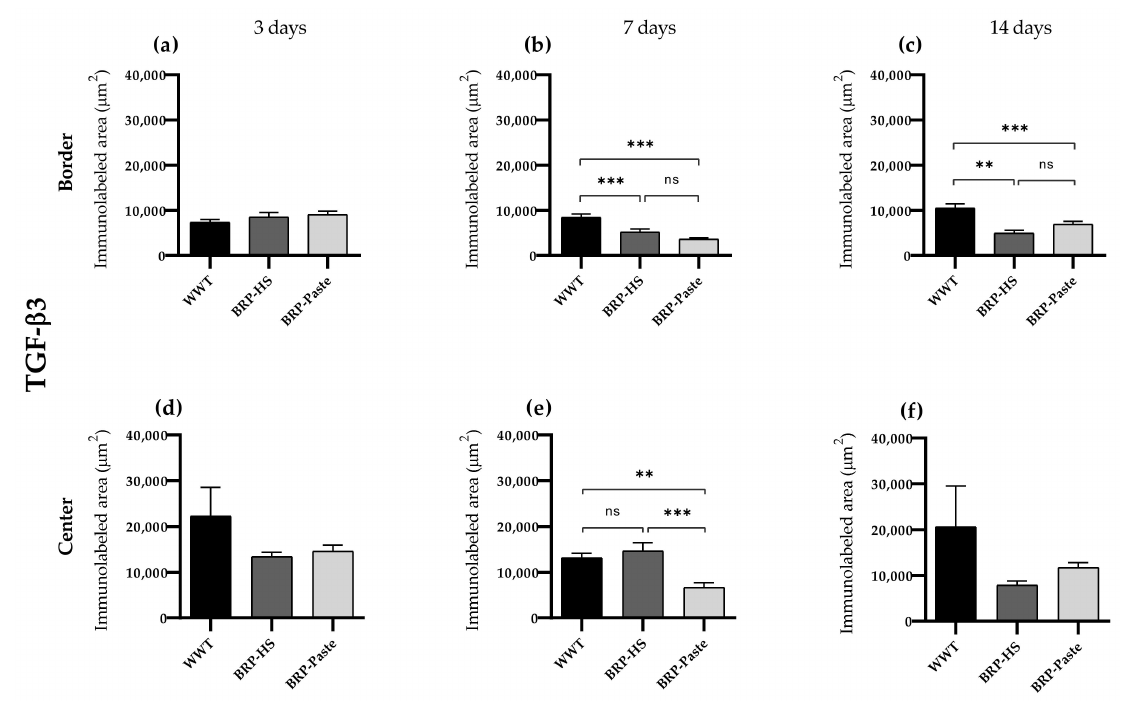
Figure 9. Quantification of TGF- β 3 by area ( µ m 2 ) at border ( a – c ) and central ( d – f ) regions (dermis) of the wounds in each experimental group for the periods of 3 ( a , d ), 7 ( b , e ) and 14 ( c , f ) days of treatment. Statistical difference compared to the WWT group was obtained by one-way ANOVA followed by Newman-Keuls test in which ** p < 0.01, and *** p < 0.001 ( n = 6). ns = no significance.